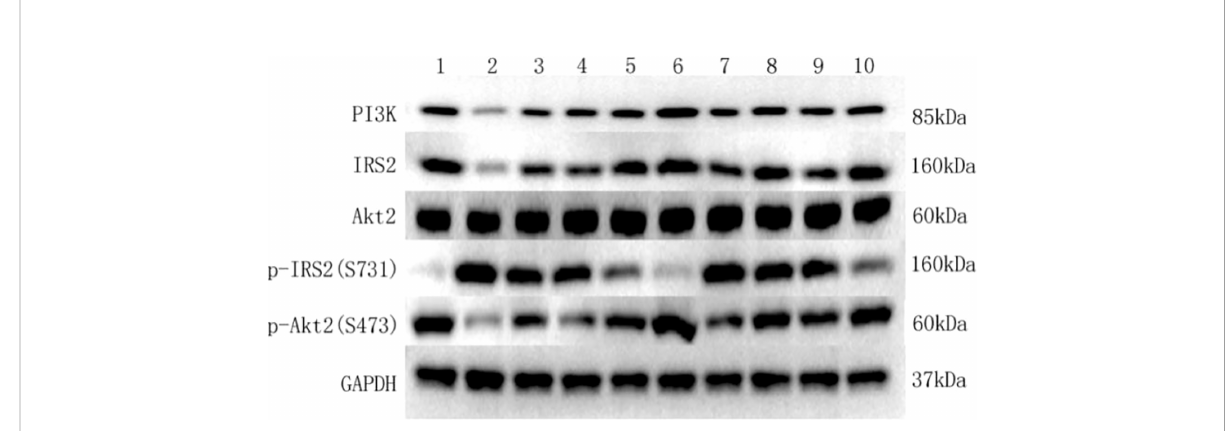
FIGURE 4 Key protein bands of insulin signaling pathway detected by western blot in each group. (1) Key protein bands in the HepG2 group. (2) Key protein bands in the HepG2+VAT group. (3) Key protein bands in the HepG2+SAT group. (4) Key protein bands in the HepG2+VAT+EXE group. (5) Key protein bands in the HepG2+SAT+EXE group. (6) Key protein bands in the HepG2+insulin group. (7) Key protein bands in the HepG2 +VAT +insulin group. (8) Key protein bands in the HepG2+SAT +insulin group. (9) Key protein bands in the HepG2+VAT+EXE +insulin group. (10) Key protein bands in the HepG2+SAT+EXE +insulin